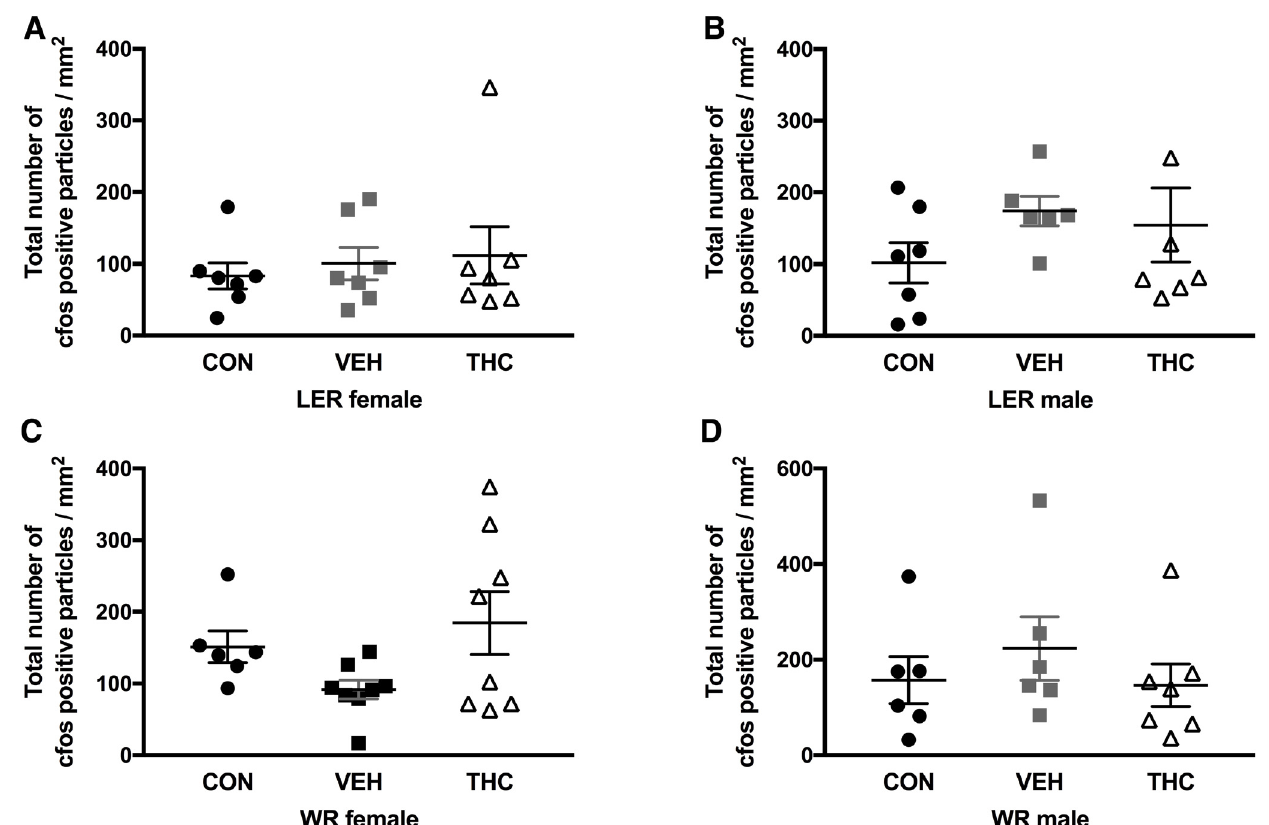
Figure 3. Cfos staining in dorsal hippocampus in LER and WR male and female rats exposed to THC as